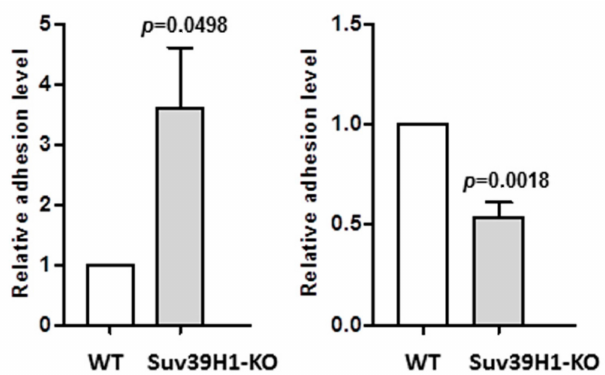
Figure 5. Adhesion assay. Left panel—adhesion of WT (white bar) and SUV39H1-KO (gray bar) HaCaT cells to a confluent monolayer of WT HaCaT cells. Right panel—adhesion of WT (white bar) and SUV39H1-KO (gray bar) HaCaT cells to the dish surface. The MTT absorbance measured in WT HaCaT cells (control) containing wells was taken as 1. The bars represent mean ± SEM calculated from the results of n = 3 experiments, each consisting of three technical